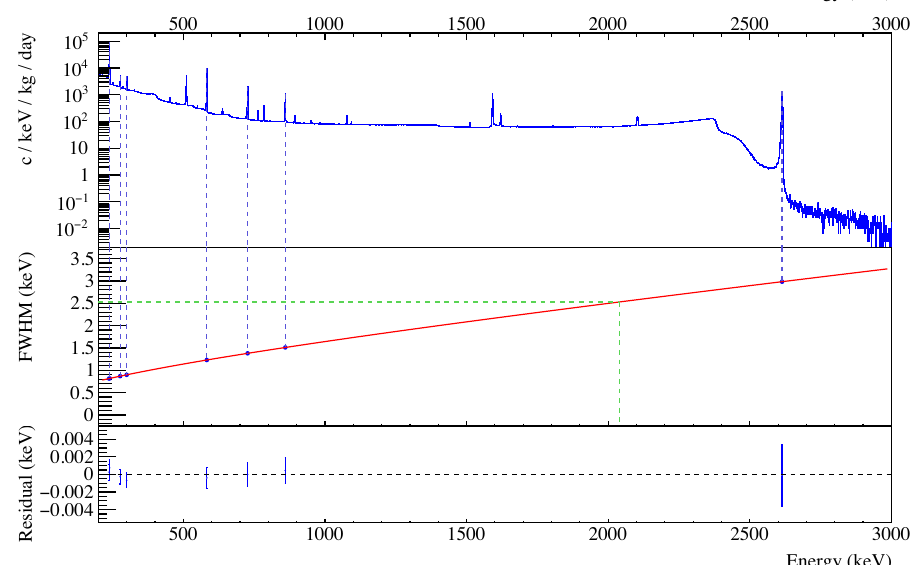
Figure 9. Top : Calibration spectrum from combined data of DS0 to DS6. Center : exposure-weighted FIG. 4. Color online. Top: combined energy spectrum from all DS0-6 calibrations. Vertical lines indicate the gamma lines used for the final energy calibration in each data set. Center: exposure-weighted resolution for each gamma peak used in resolution for all the calibration peaks and the FWHM fit function (red line). The green line indicates the calibration and a fit to the exposure-weighted values. The horizontal green line indicates the exposure-weighted average the exposure-weighted resolution value at 2039 keV. Bottom : residuals of the estimated FWHM resolution of 2.53 keV at 2039 keV. Bottom: residuals from the fit in the center panel. values from the fit. Figure published by Phys. Rev. C, 2019